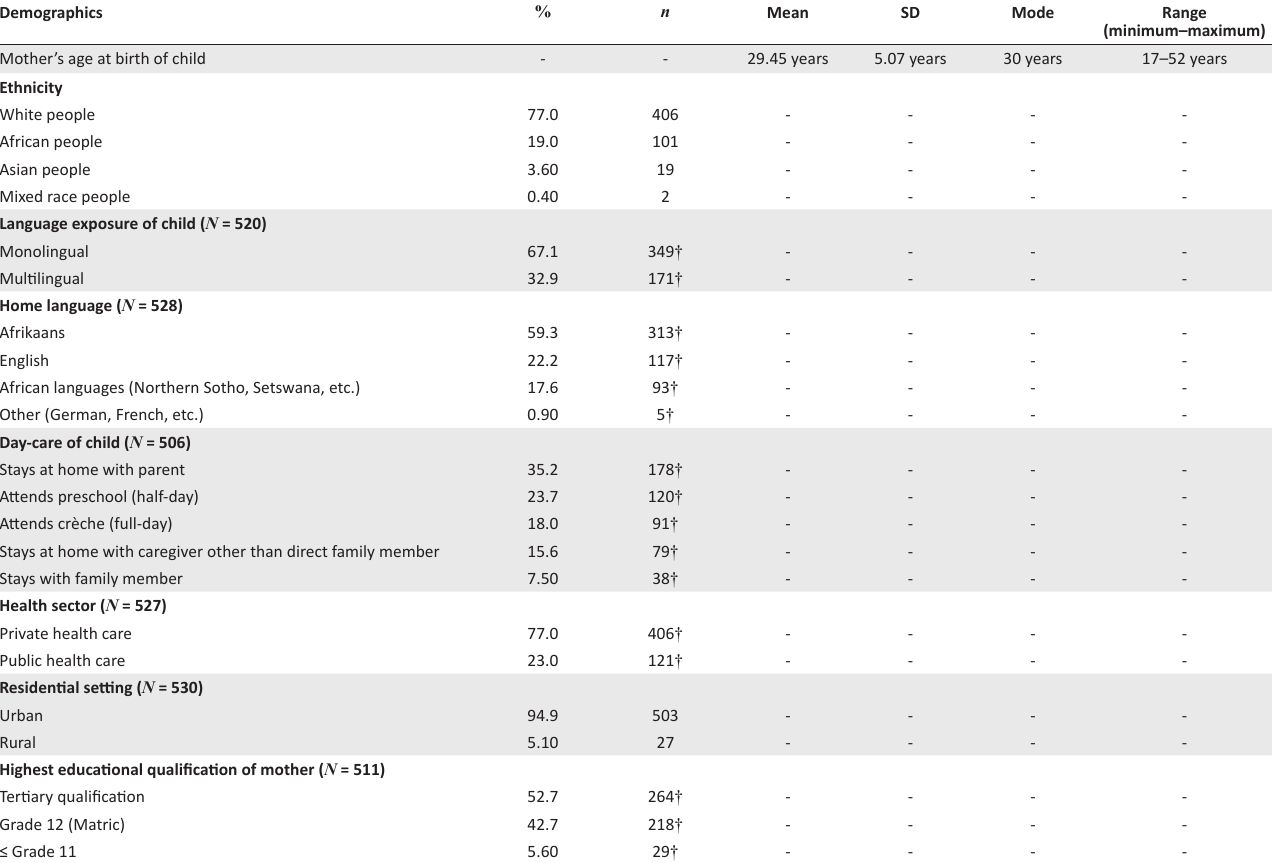
TABLE 1: Demographical characteristics of study